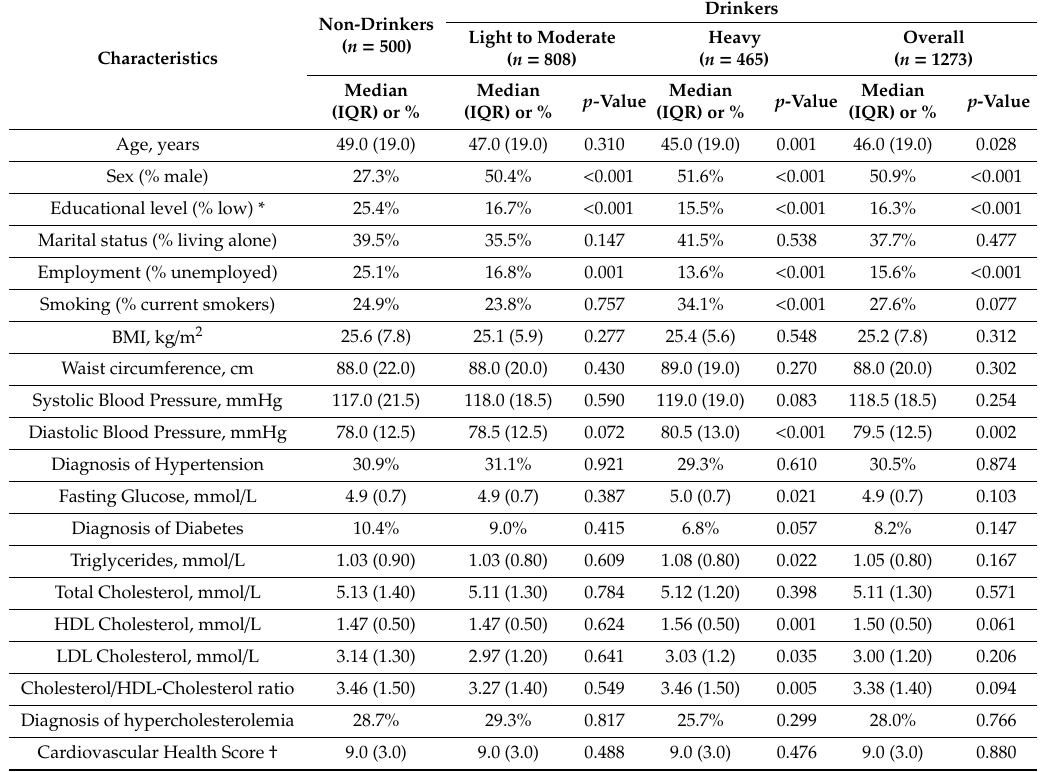
Table 1. Comparison of socio-demographic characteristics and cardiovascular diseases (CVD) risk factors between drinkers and